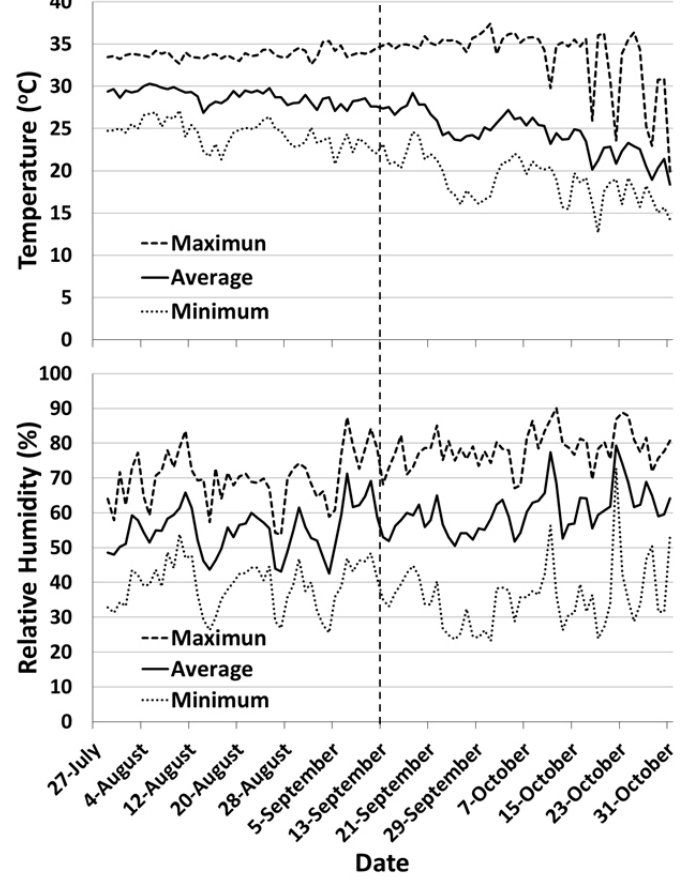
Figure 2. Glasshouse maximum, average, and minimum air temperature ( ◦ C) and relative humidity (%) for the whole duration of the study (29 July–31 October 2016). The dashed line separates the seawater irrigation stress period from the recovery period.